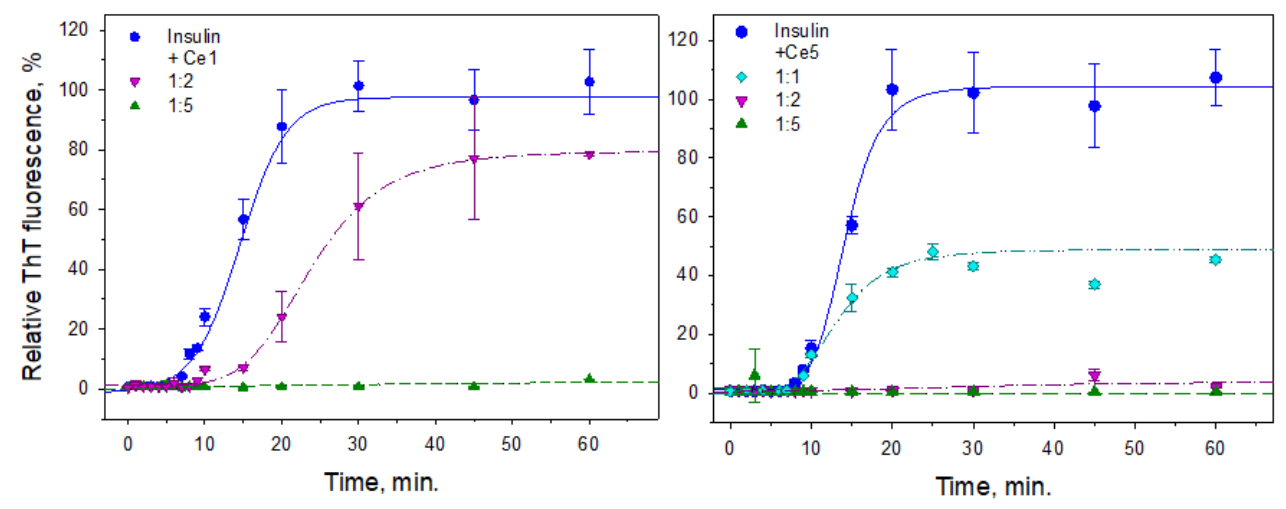
Figure 3. Time dependence of insulin fibrillization in the presence of CeO 2 NPs evaluated by ThT assay. Ce1 ( left panel ) and Ce5 ( right panel ) particles were added to the freshly prepared insulin solution and samples were exposed to fibrillization conditions with and without CeO 2 NP.